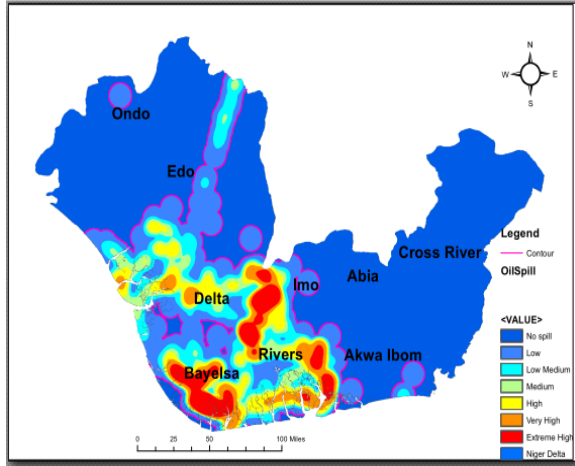
Figure 4. Oil spill hotspot map of KDE of the Niger Delta Region